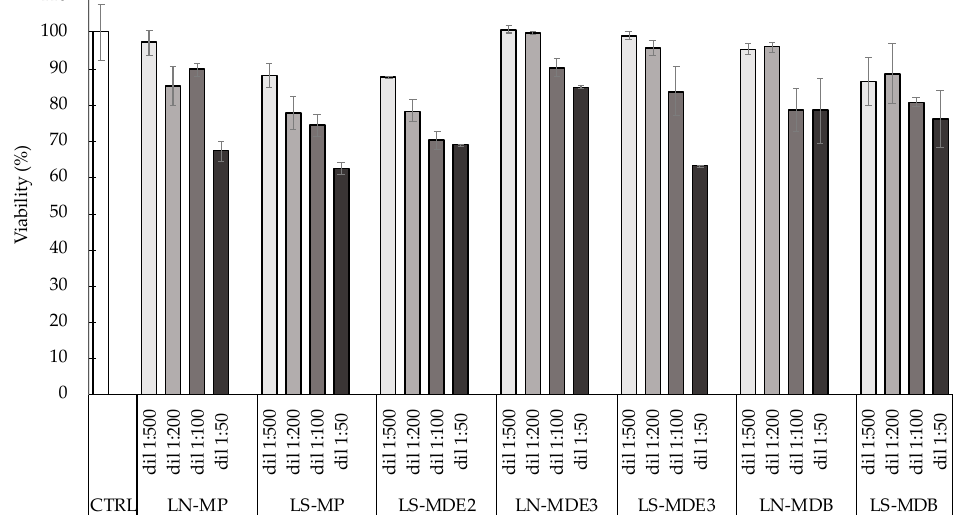
Figure 9. Effect of loaded LN and LS on cultured cells in vitro evaluated by MTT. Data are the means of three independent experiments ± SD conducted in triplicate.